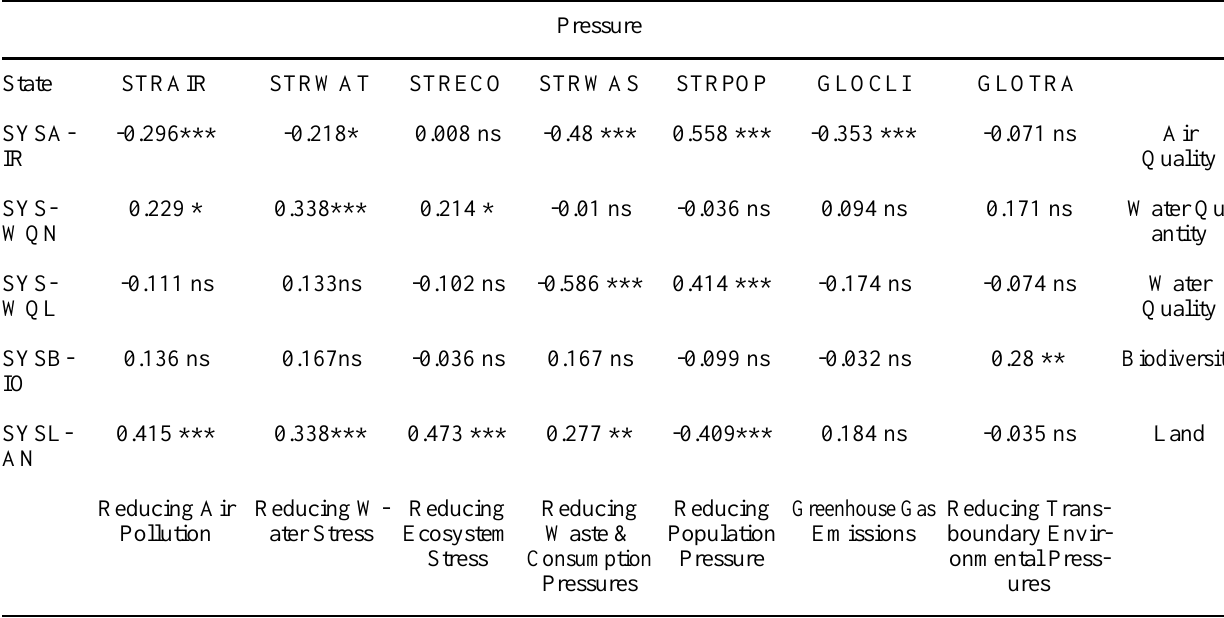
Table 3. Correlation coefficients for the PSIR components of the ESI 2002 data